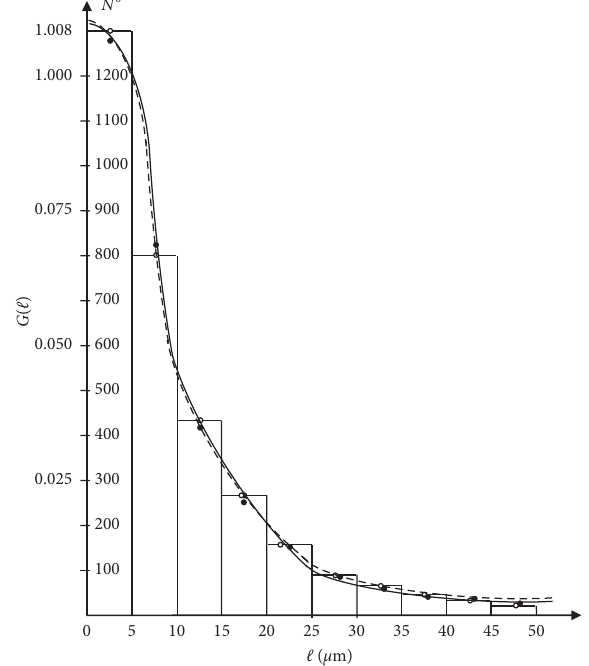
Figure 9: The histogram and the curve of the distribution of the lengths of the ext-chords of adjacent fibers (circles) G ( ℓ ): exper- imental ordinates ( ○ ); model ordinates ( ● ) and a model curve for the distribution of the lengths of the ext-chords of neighboring fibers ( ── ); N o is the number of